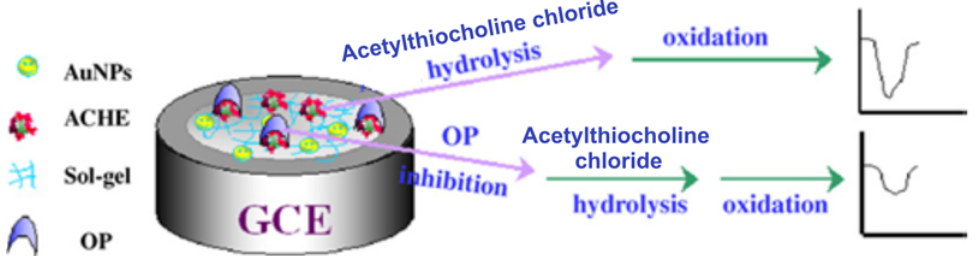
Figure 6. Principle of AChE sensor used for determination of OP compound (reproduced with permission from Du et al.